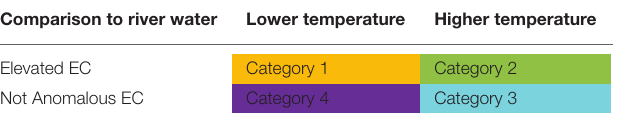
TABLE 1 | Water quality anomaly categories (4) based on observed electrical conductivity (EC) and water temperature from the sensors on the riverbed, relative to river water column observations.